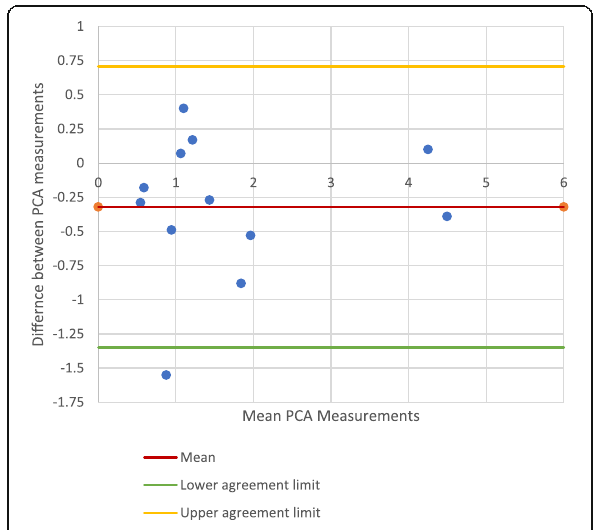
Fig. 5 PCA measurements on anatomical axis-photography vs . CT